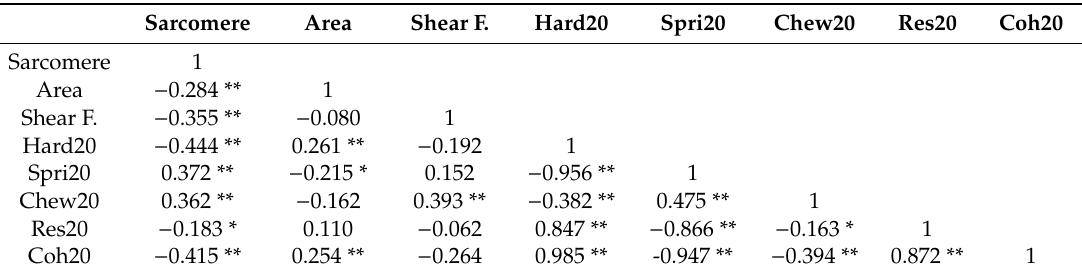
Table 4. Pearson’s correlation coe ffi cient ( r ) between histological and texture parameters of Longissimus thoracis from calves of the Retinta breed. Sarcomere Area Shear F. Hard20 Spri20 Chew20 Res20 Coh20